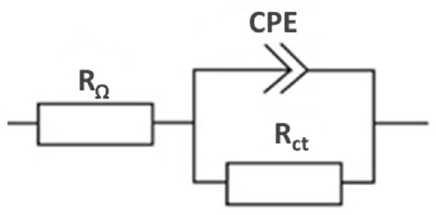
Figure 3. Equivalent